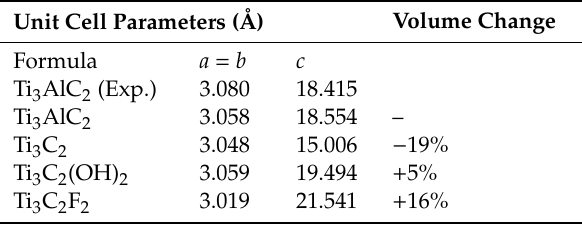
Table 2. Summary of the Density functional theory (DFT) calculation results of titanium carbides MAX phases and MXenes from Naguib et al., with permission from Reference [61], copyright (2015) John Wiley and